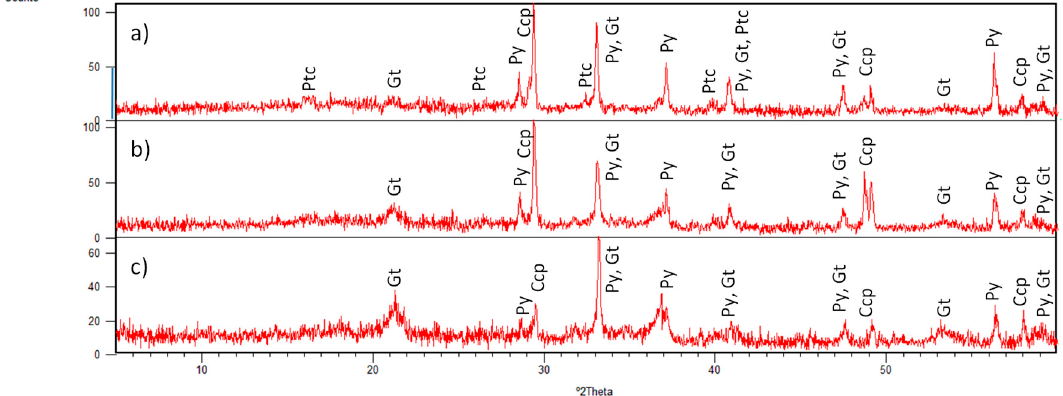
Figure 7. Image of the sediment core GC-702 with sampling points (white circles).